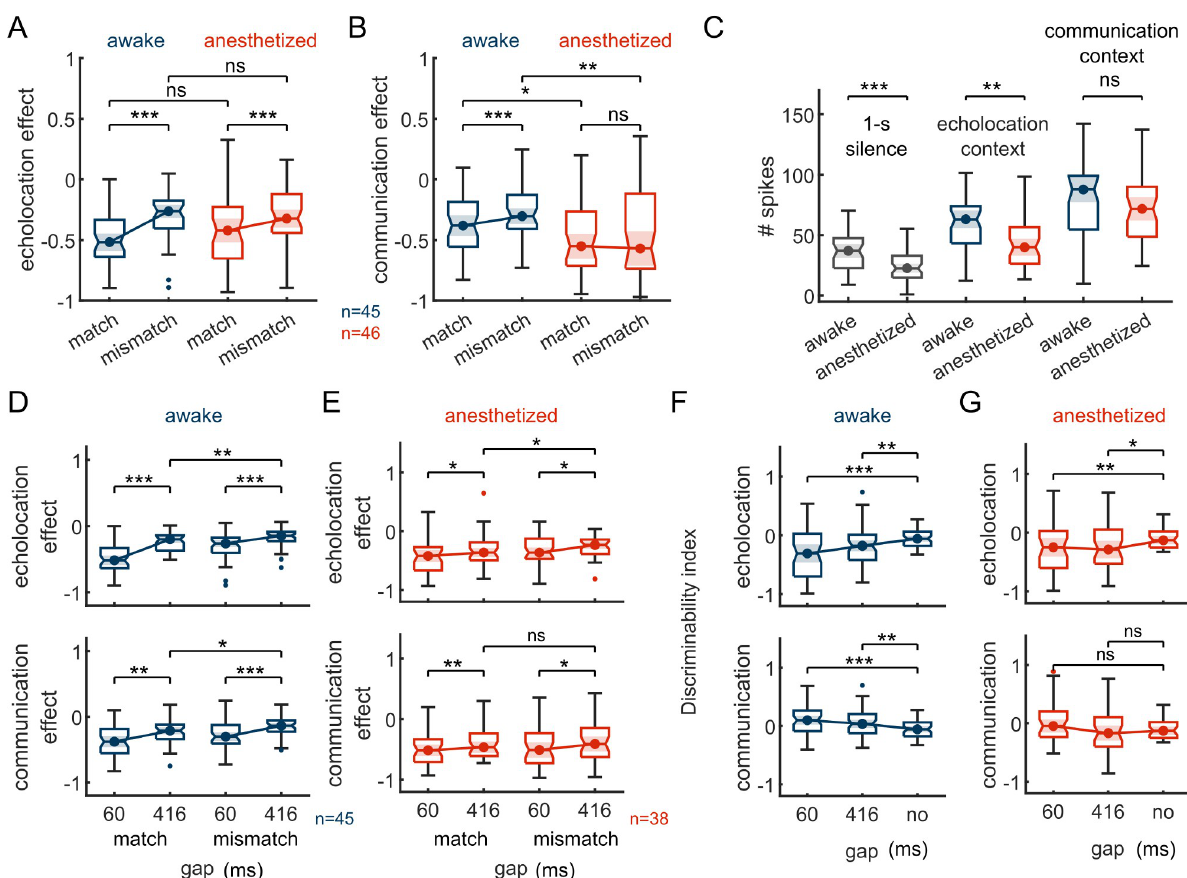
Fig 7. Stronger suppression on both probes after communication context explains decrement on s.s.s. under anaesthesia. ( A ) Context effect on probe-responses following an echolocation sequence. In blue, neurons recorded from awake bats ( n = 45); in red, from anaesthetized ( n = 46). ( B ) Context effect after communication context. ( C ) Spike counts during 1 second of silence, the echolocation context, and the communication context; for awake and anaesthetized preparations. ( D ) Top: comparisons between context effect after echolocation context with a gap of 60 ms and 416 ms between probe onset and context offset in awake animals. Bottom: same than above, but after communication context. ( E ) Same than in “D” but in anaesthetized animals. ( F ) Discriminability index calculated after 60 and 416 ms from the offset of the echolocation (top) and communication context (bottom) and after no context in the awake preparation ( n = 45). ( G ) Same than in “F” but the neurons were recorded in anaesthetized bats ( n = 38). Statistical tests within preparations were obtained using a paired test (Wilcoxon signed-rank). Statistical differences between awake and anaesthetized preparations were obtained using Wilcoxon rank-sum test. Data supporting this figure can be found in the files “all_data.mat,” “inj_data.mat,” “chi_data.mat,” “sp_context.mat,” and “all_ce.mat” in “Ephys data” folder in https://gin.g-node.org/Luciana/anesthesia_bats. The underlying codes for each panel are in the same